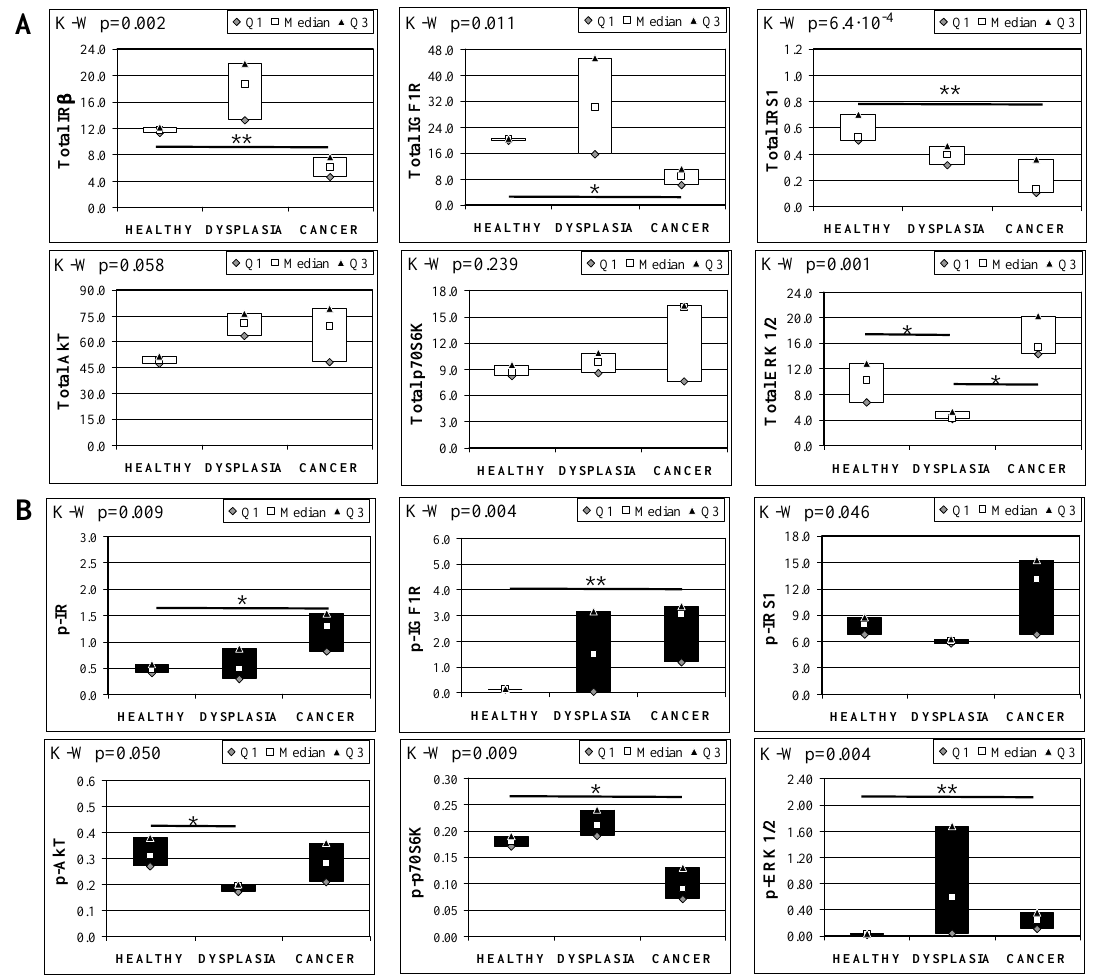
Figure 4. Insulin signaling in operated MKR female mice esophageal tissue. Data are represented as Median (Q1; Q3). Data obtained in operated mice affected by dysplasia or cancer were compared to strain-, sex-, and age-matched, non-operated animals (43 weeks). K-W indicates the Kruskal-Wallis test result, used for multiple comparisons among the three groups of mice. Mann-Whitney U-test was performed to compare data distribution between two groups of mice. A p -value lower than 0.016 (Bonferroni adjustment) was considered statistically significant: * p < 0.016; ** p < 1.6 × 10 − 3 . ( A ) Total protein expression: the quantity of each total protein considered was expressed in ng/100 mg of total protein extracted by the distal mice esophageal segment. ( B ) Phosphorylated protein expression: the amount of the six phospho-proteins considered was expressed as phosphorylated Units for each ng of the corresponding total protein amount. Proteins were quantified by Luminex-xMAP Technology on the basis of a standard curve. Beta-tubulin expression was used as the internal loading